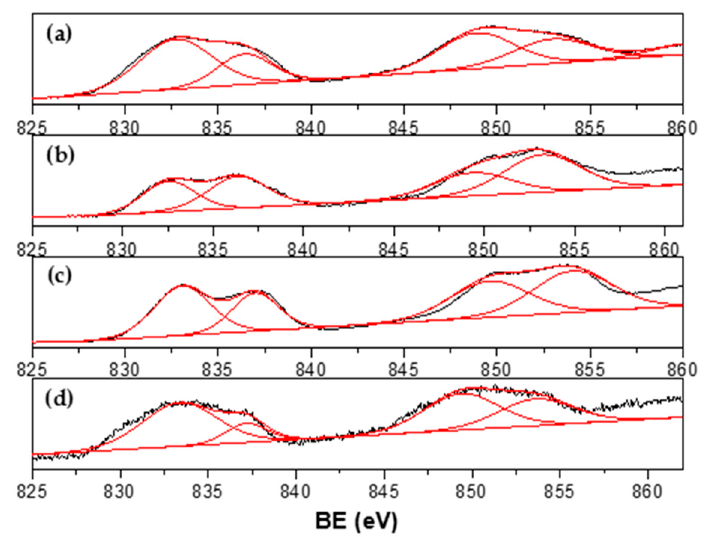
Figure 10. La 3d spectra of Ni 1-x Co x / La 0.8 Ce 0.2 catalysts. ( a ) Co; ( b ) Ni 0.1 Co 0.9 ; ( c ) Ni 0.4 Co 0.6 ; and ( d ) Ni 0.7 Co 0.3 .